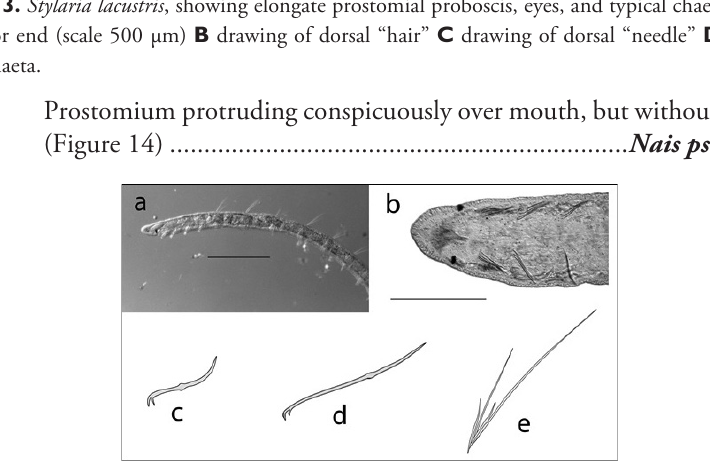
Figure 14. Nais pseudobtusa : A lateral photo of anterior end showing arrangement of chaetae, eyes, and over- hanging prostomium (scale 500 µm) B dorsal photo of anterior end (scale 250 µm) C drawing of typical pos- terior-ventral chaeta D drawing of typical anterior-ventral chaeta D drawing of typical bundle of dorsal